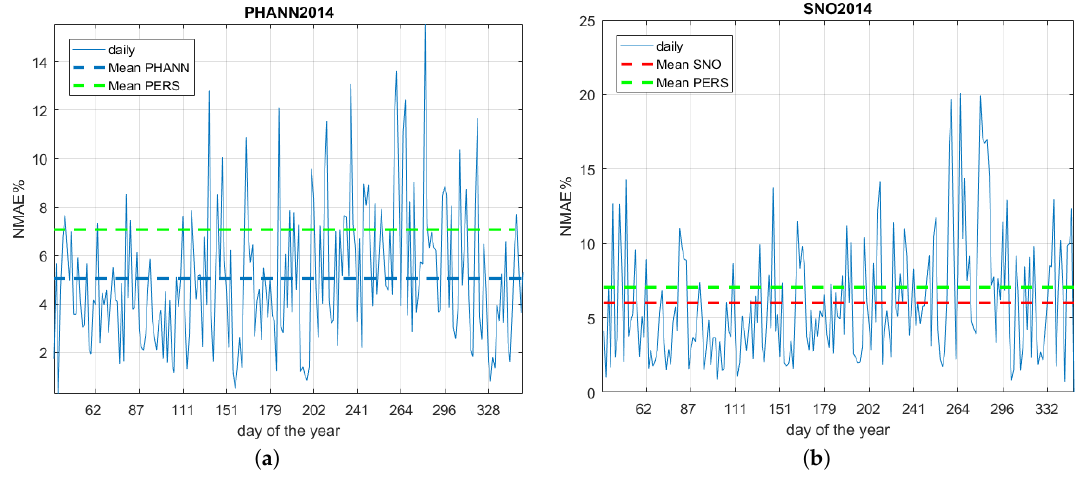
Figure 7. Daily NMAE% for 2014: ( a ) PHANN; and ( b ) SNO based